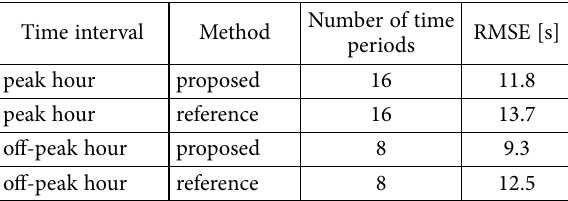
Table 1. Control delay estimation error